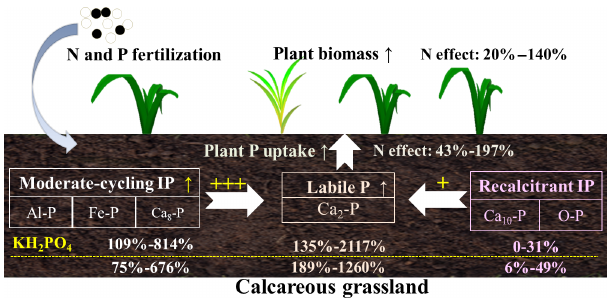
Figure 7. Schematic diagram shows the effects of phosphorus (P) compound addition on soil inorganic P transformations in the cal- careous grassland of Inner Mongolia. The percentages represent in- crease (“ ↑ ” in the diagram) of soil inorganic P fractions, plant P up- take and plant biomass as affected by fertilization across P addition rates. KH 2 PO 4 addition had a larger impact on moderate-cycling IP (sum of Al-P, Fe-P and Ca 8 -P) as compared to Ca ( H 2 PO 4 ) 2 (109%–814% vs. 75%–676%). However, recalcitrant P (sum of Ca 10 -P and O-P) increased more with Ca ( H 2 PO 4 ) 2 addition rela- tive to KH 2 PO 4 (6%–49% vs. 0%–31%). Nitrogen addition de- creased moderate-cycling P by enhancing plant biomass and plant P uptake for both P compound additions across P addition rates. Therefore, moderate-cycling P showed a higher contribution to soil labile P than recalcitrant P, as represented by “ +++ ” and “ + ”,